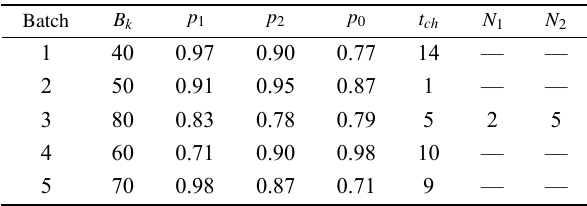
We use Monte Carlo simulation and Markovian analysis to evaluate the dynamic performance of the Table 2 Parameters of three-machine assembly